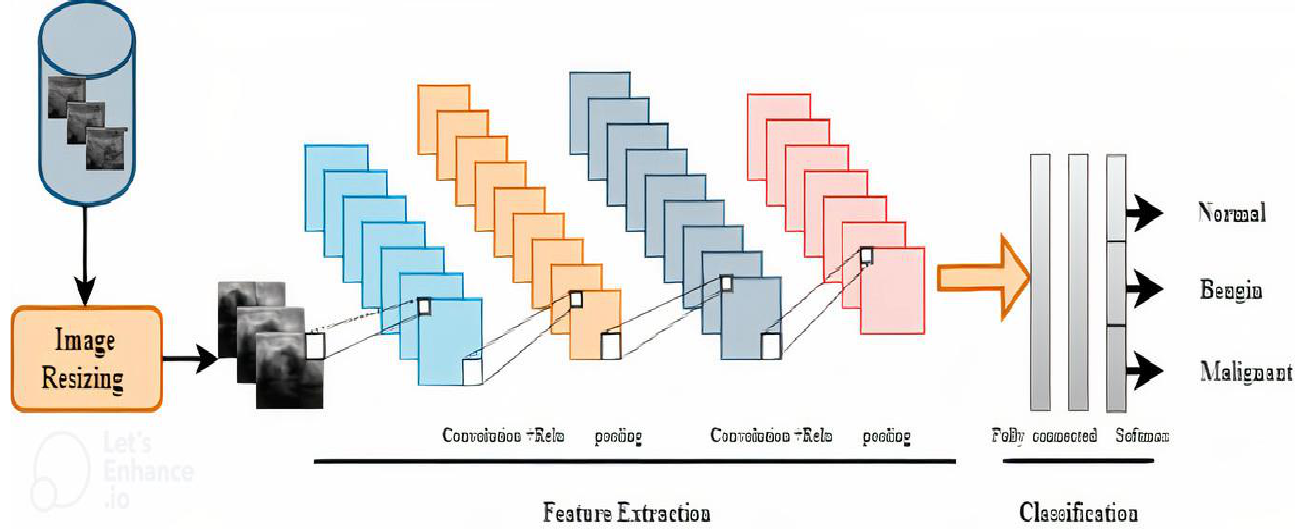
Figure 2. The abstract perspective of the proposed DeepBreasCancertNet technique.